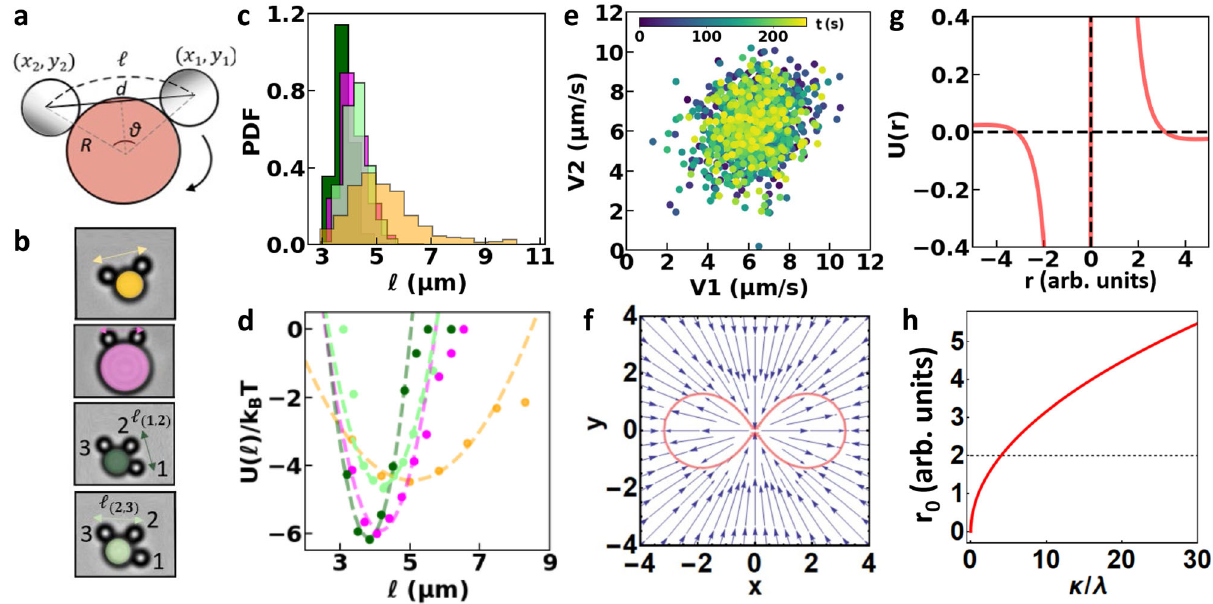
Fig. 3 Interactions of microswimmers comoving along circular posts: experiment and modeling. a Representation of the arc distance for two swimmers orbiting in the clockwise direction away from their Pt-coated shaded caps. b Snapshots of swimmer pairs in orbit, color-coded so that each color marks the corresponding swimmer pair in panels c and d . c PDF of the arc distance between comoving swimmers, showing that swimmers assume a relatively constant distance in orbit with minimum center-to-center distance ≈ 3 μ m. Measurement duration is ≈ 5 min. d Potential energy in units of thermal energy, as obtained from the swimmer distances in c using the Boltzmann distribution. The dashed lines represent least-squares fi ts with y ¼ 1 fi tted parameters are listed in the Supplementary Information (SI). e Scatter plot of the speeds of the two swimmers comoving along the 8 μ m post colored magenta in panels b – d , showing that swimmer speeds are not correlated. f – h Effective separation between swimmers based on hydrodynamic and osmotic balance. f The balance between an inward osmotic fl ow along the wall and an outward pusher-type dipolar fl ow away from the swimmer leads to a curve of zero velocity depicted in red. g Two swimmers that lie head-to-tail as in panel ( a ) assume a fi xed distance as evidenced by the x -axis intercept. The shape of the relative velocity generates an effective potential. h Swimmer separation distance as a function of the ratio between the osmotic and pusher contributions, with λ and κ indicating the respective strengths of the inward and outward fl ows. f – h See Supplementary Information for details and the used code, together with an in-depth analysis that additionally accounts for the asymmetric Pt cap and swimmer trains of up to six